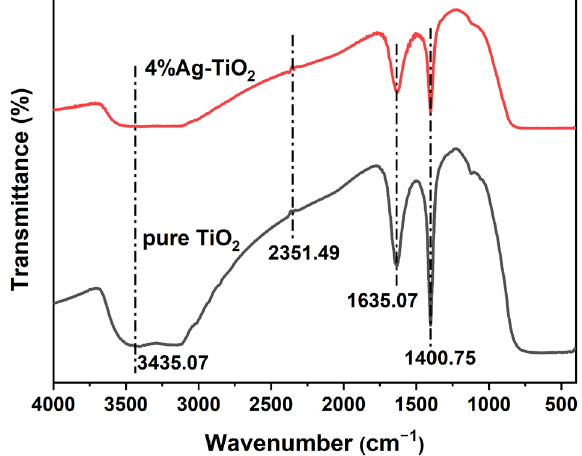
Figure 6. FTIR spectra of pure TiO 2 and 4%Ag-TiO 2